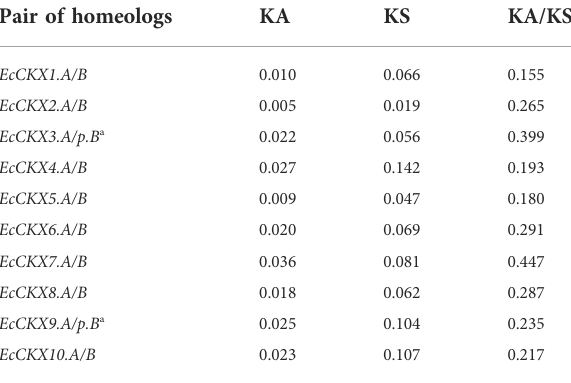
TABLE 2 Rates of (non-)synonymous substitutions within homologous pairs of EcCKX . Pair of homeologs